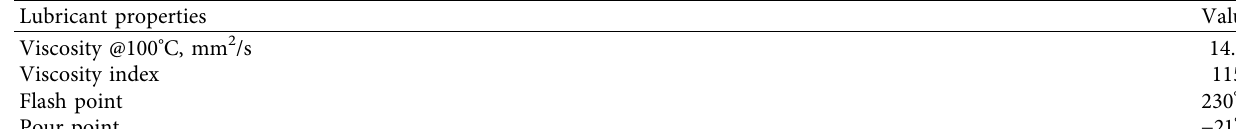
Table 3: Properties of lubricant oil grade SAE20W40.